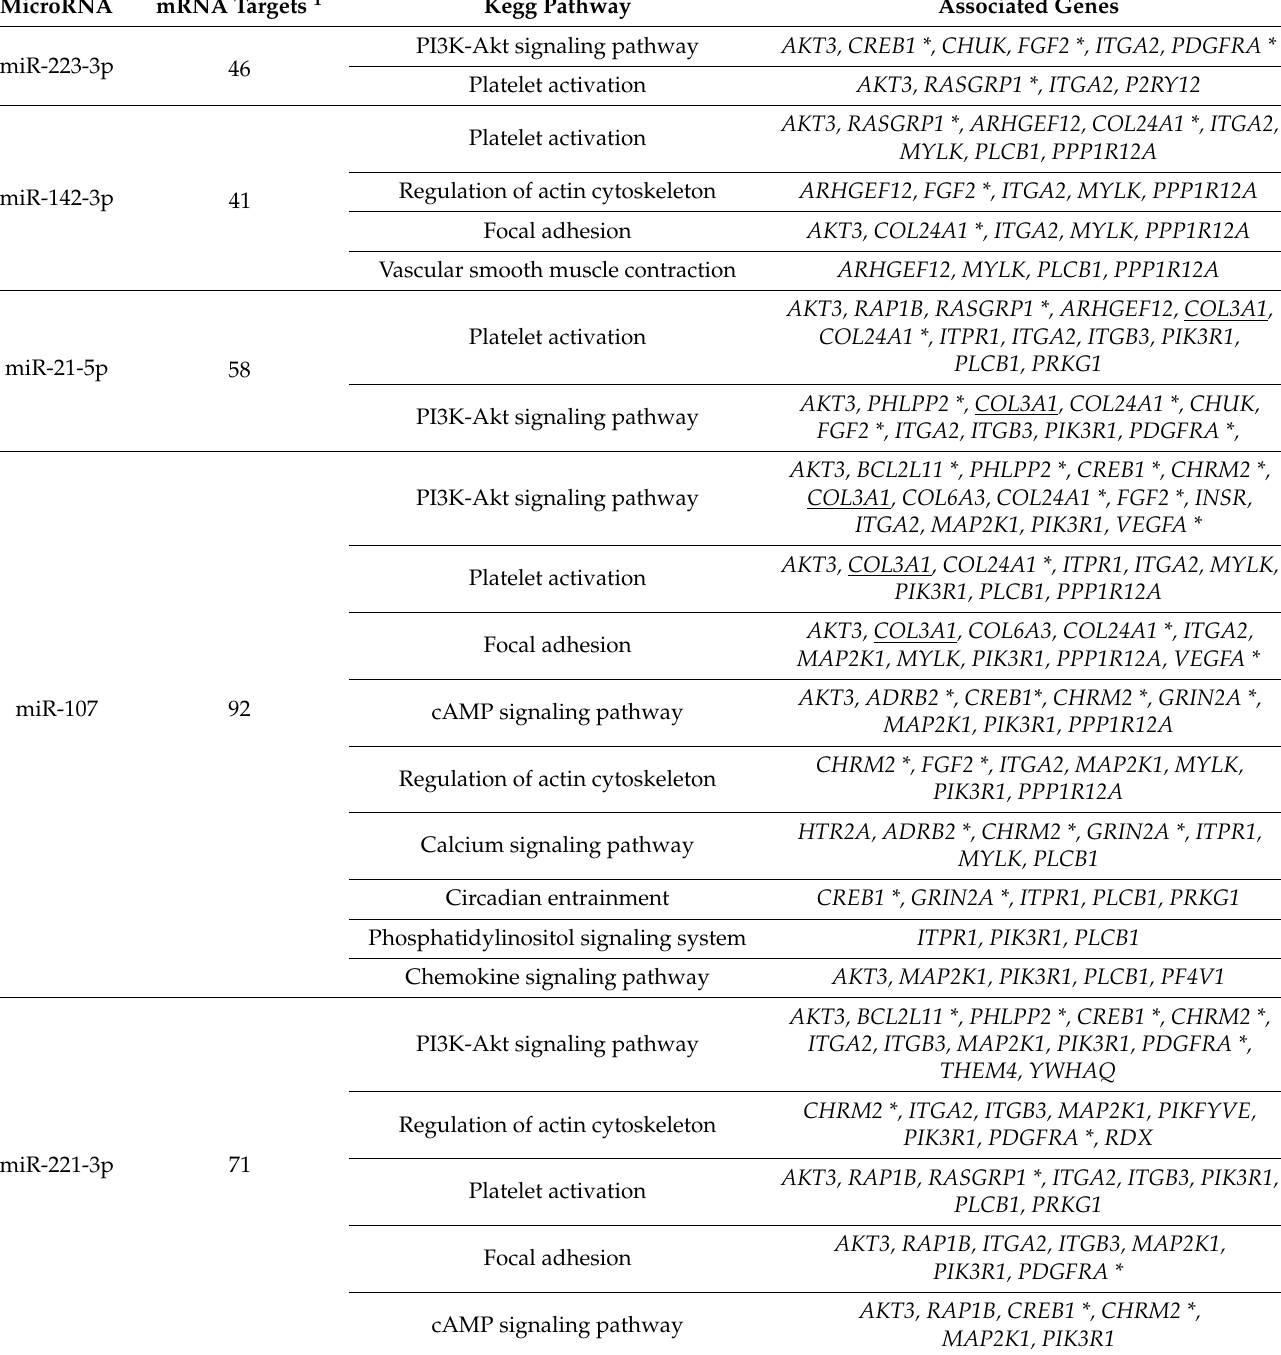
Table 3. Summary of predictive mRNA-miRNA targets associated with the central biological functions of blood platelets.